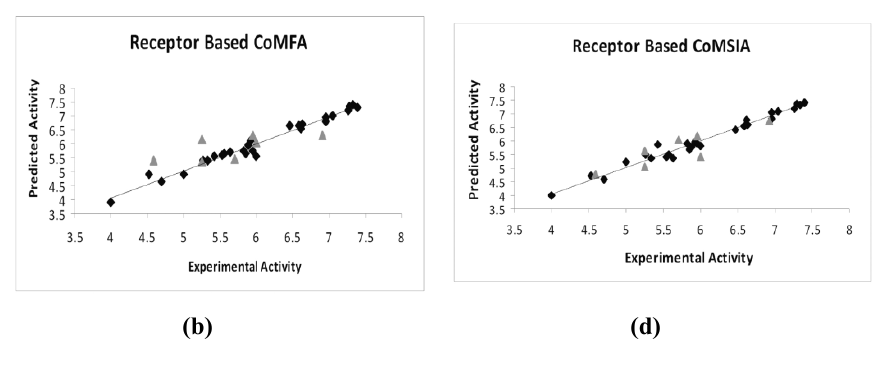
Figure 3. Scatter plot of observed versus predicted pIC the test set (▲) molecules based on (a)Ligand based CoMFA model,(b) Ligand based CoMSIA model, (c) Receptor based CoMFA model and (d) Receptor based CoMSIA